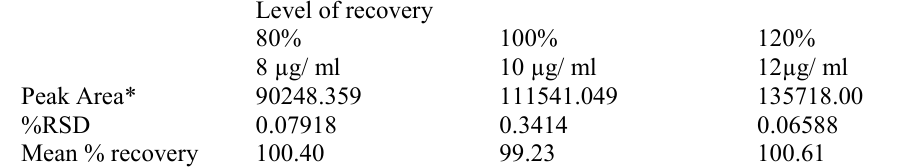
Table 3. Recovery studies of Atorvastatin Calcium Excepted concentration.